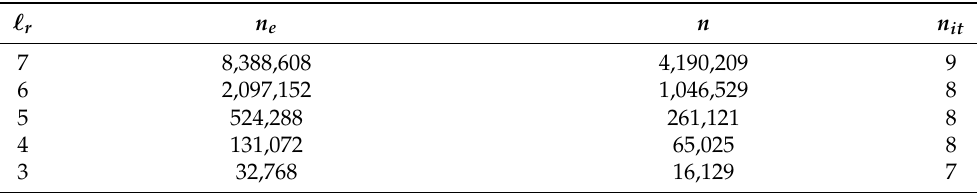
Table 5. Number of finite elements n e , number of unknowns n , and number of PCG iterations n it with preconditioner C BURA : (cid:96) r levels of uniform mesh refinements, σ 1 σ 2 = 2, and stopping DD ,12